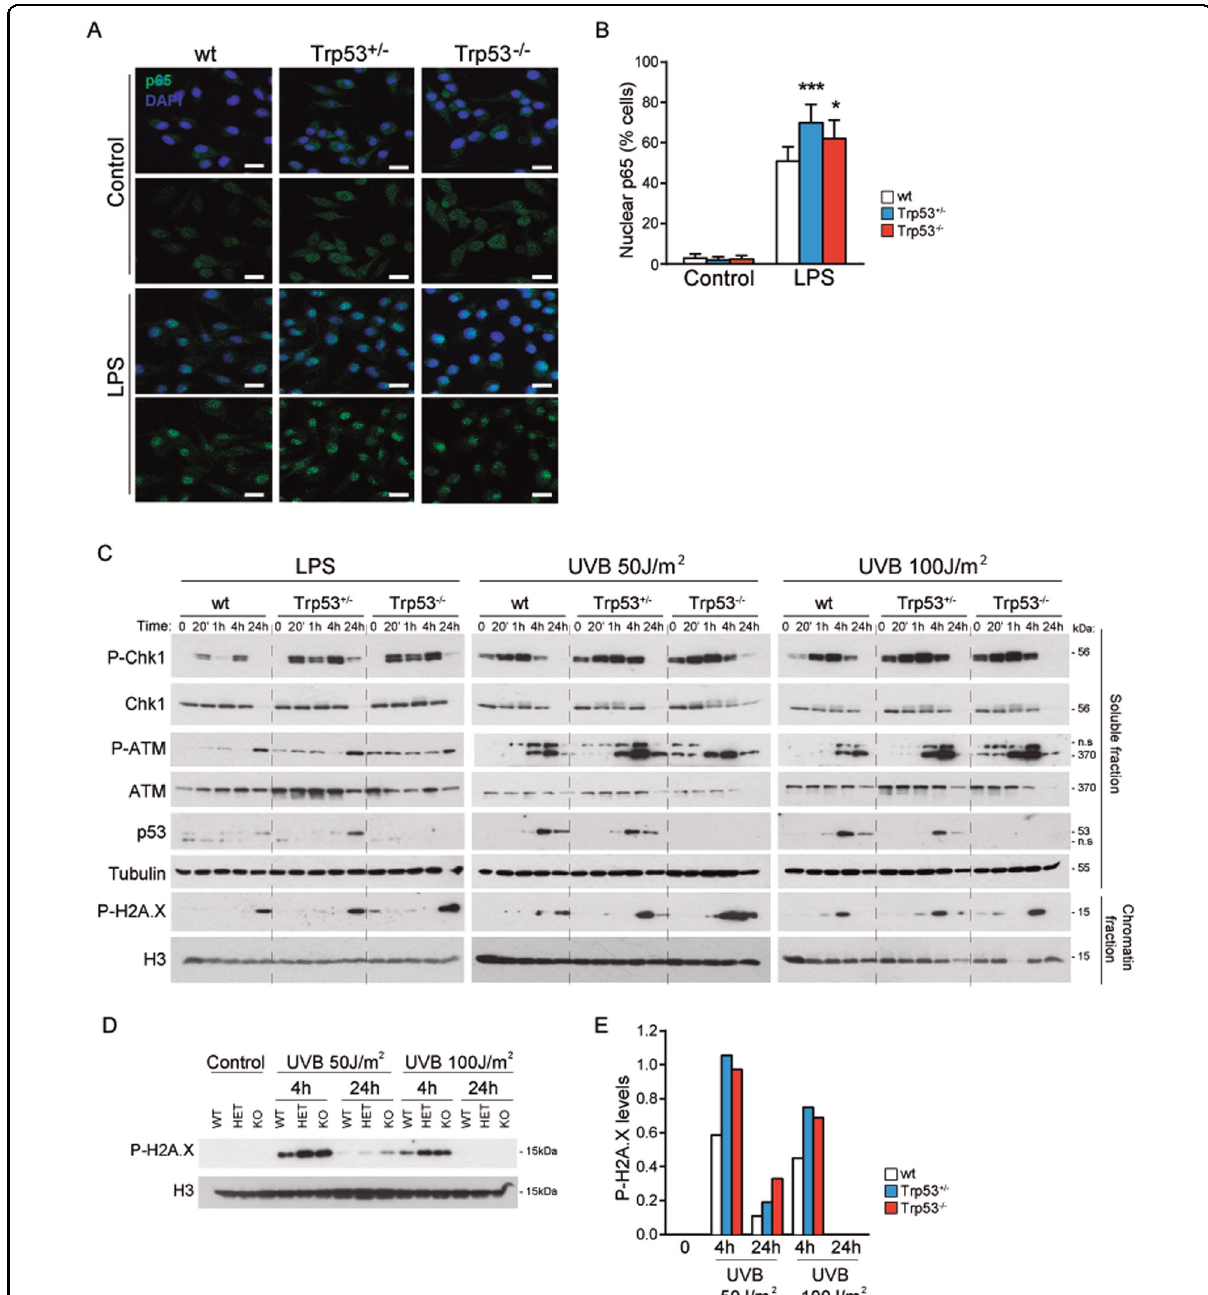
Fig. 4 Loss of one Trp53 allele leads to increased p65/NF- κ B nuclear localization and increased DNA damage response in LPS- and UVB- treated BMDM cells. A Representative p65 immuno fl uorescence images of untreated (Control) and treated (LPS, 100 ng/ml, 15 min) BMDMs from p53 WT, HEM and KO mice. B Quanti fi cation of the percentage (%) of cells positive for nuclear p65 localization in control and LPS (100ng/ml, 15 min)- treated BMDMs. A minimum of 500 cells per genotype was counted in two independent experiments. C Expression of DNA damage response proteins in BMDMs treated with LPS (100 ng/ml) or UVB (50 J/m 2 and 100 J/m 2 ) for 4 or 24 h (h) from p53 WT, HEM, and KO mice. Representative images of western blot analysis from two independent experiments are shown. n.s. non-speci fi c band. D Expression of P-H2A.X in BMDMs treated with UVB (50 J/m 2 and 100 J/m 2 ) for 4 or 24 h (h) from p53 WT, HEM, and KO mice. Representative images of western blot analysis from two independent experiments are shown. E Quanti fi cation of western blot analysis (in D ) of UVB-treated WT, HEM, and KO BMDMs. Means of two independent experiments are shown. In A , scale bars are 25 μ m. In B , bars represent mean values ± SEM. AU arbitrary units. Signi fi cant differences and p values derived from an unpaired t -test, two-tailed. WT vs HEM or KO: *** p value < 0.0005, * p value < 0.05.